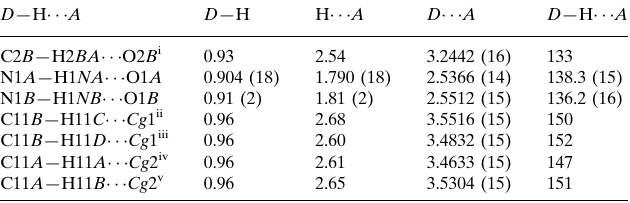
Hydrogen-bond geometry (A˚ , (cid:3)